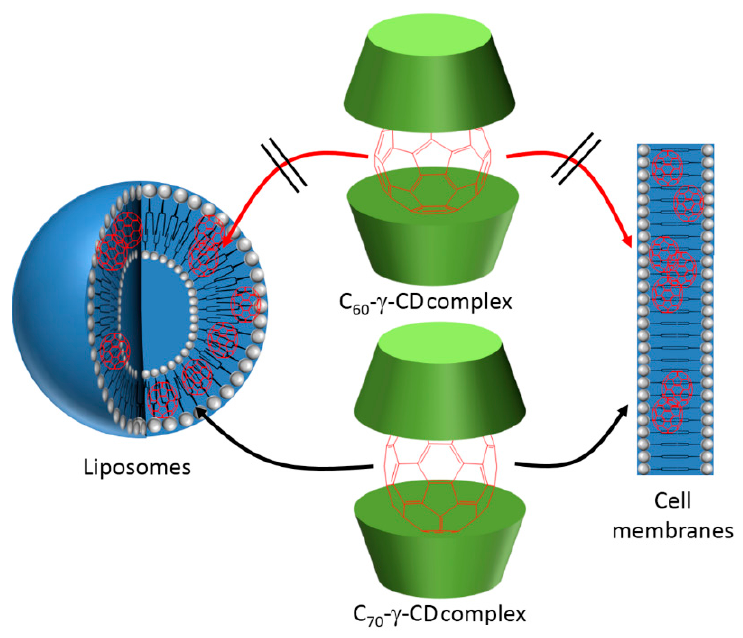
Figure 63. Schematic illustration of the exchange reaction from γ -CD cavity to the liposomal and cell membranes at 37 °C. Adapted from Ikeda; Matsumoto; Akiyama; Kikuchi; Ogawa; Takeya [214].